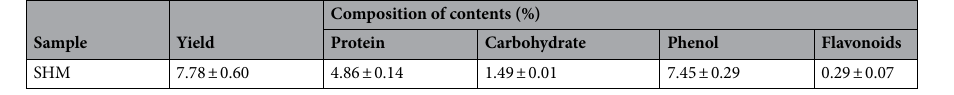
Table 1. Yield and composition of major chemical constituents in the methanol extract of S. horneri .